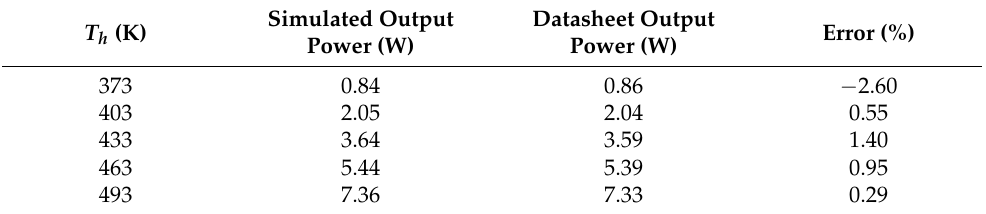
Table 3. Error between simulated and manufacturer data of output power for a single TEM at different hot side temperatures ( T h ) with a cold side temperature T c = 323